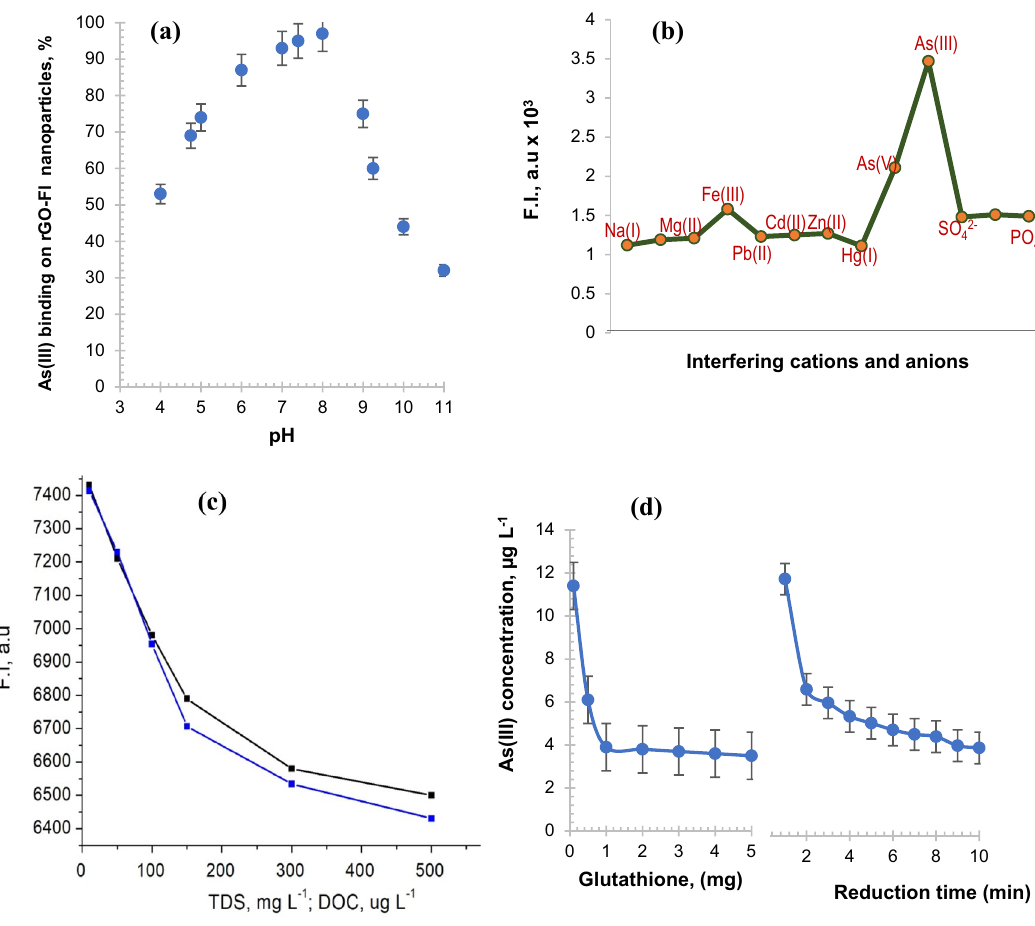
Figure 5. ( a ) Effect of pH on the fluorescence emission of rGO–FL nanoparticles ( b ) Interference of metal ions and common anion during detection of As(III) by the rGO–FL nanoparticle sensor ( c ) Interference of total dissolved solids (TDS) and dissolved organic carbon (DOC) during As(III) detection by using rGO–FL nanoparticle sensor ( d ) quantity of glutathione required for reduction of As(V) to As(III) and the time of